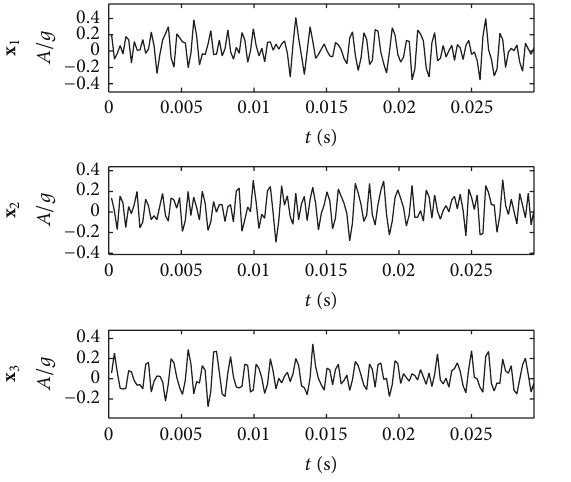
Figure 8: Waveforms of separated components.